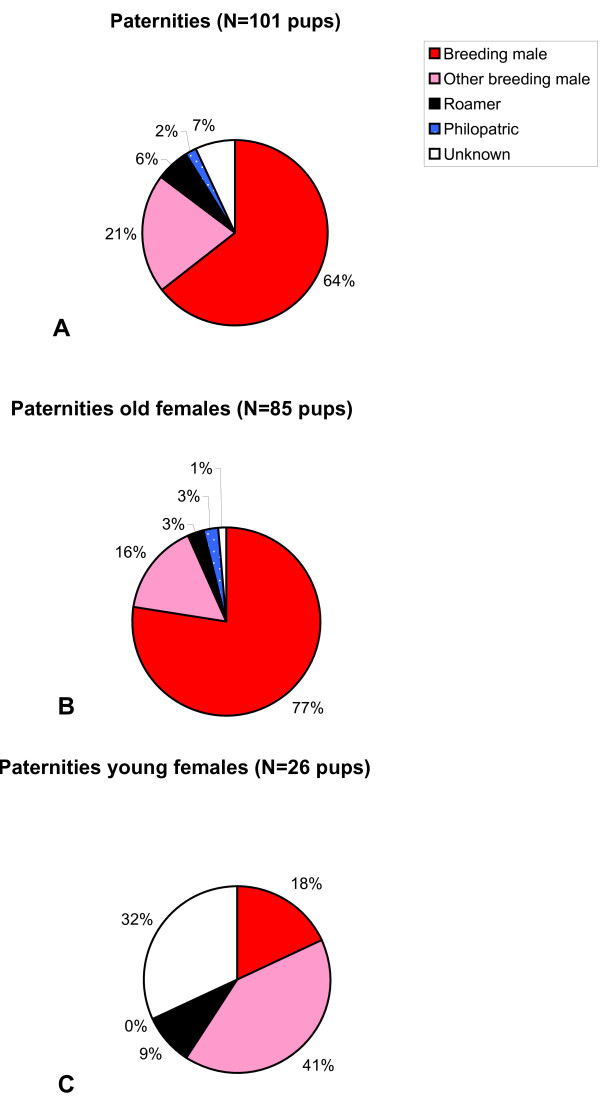
Paternity within groups by the breeding male of the group, neighbouring breeding males, roamers, philopatrics and unknown males, for A) entire groups, B) old breeding females, C) young philopatric females.